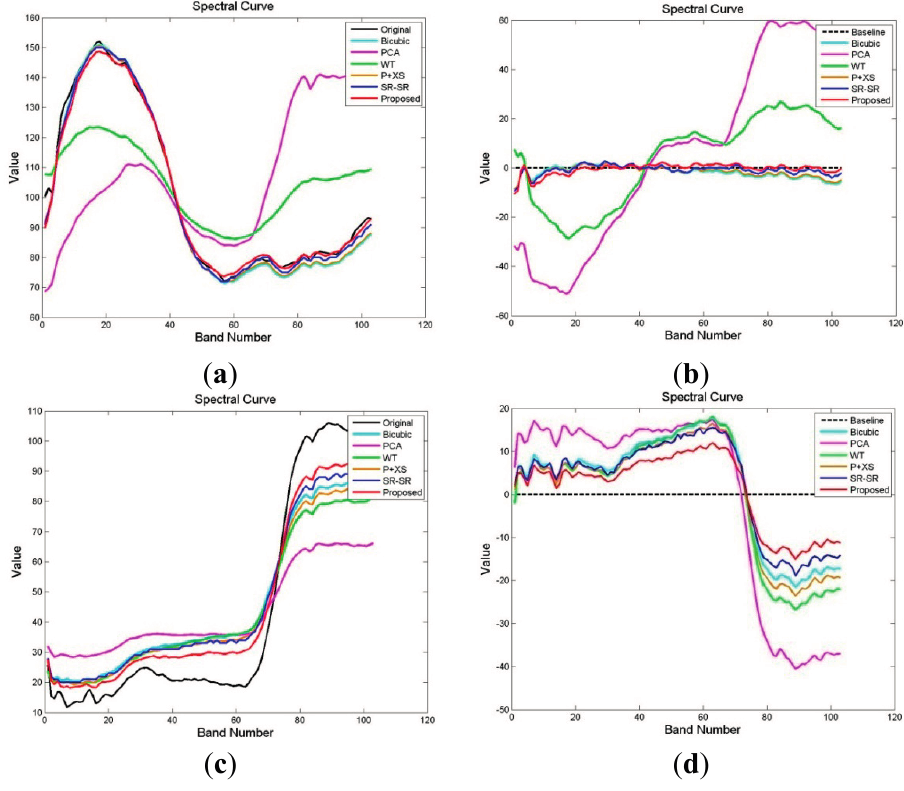
Figure 5. Spectral curves of two typical pixels, one is metal material (the coordinate located at (72,129)), the other is meadow material (the coordinate located at (127,173)). ( a ) the spectral curves of the metal material; ( b ) the pixel curves of the metal material in difference HSI; ( c ) the spectral curves of the meadow material; ( d ) the pixel curves of the meadow material in difference HSI.